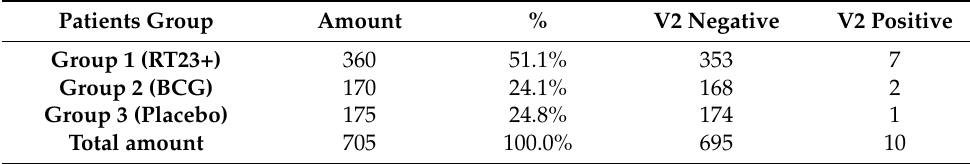
Table 10. Division of the study participants into three treatment groups.